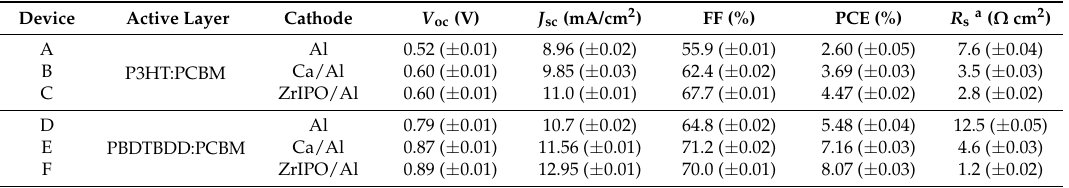
Table 1. Device parameters (averaged over 12 individual devices) of the PSCs with different cathode buffer layer (CBL) in the dark and under the illumination of AM1.5G, 100 mW/cm 2 .